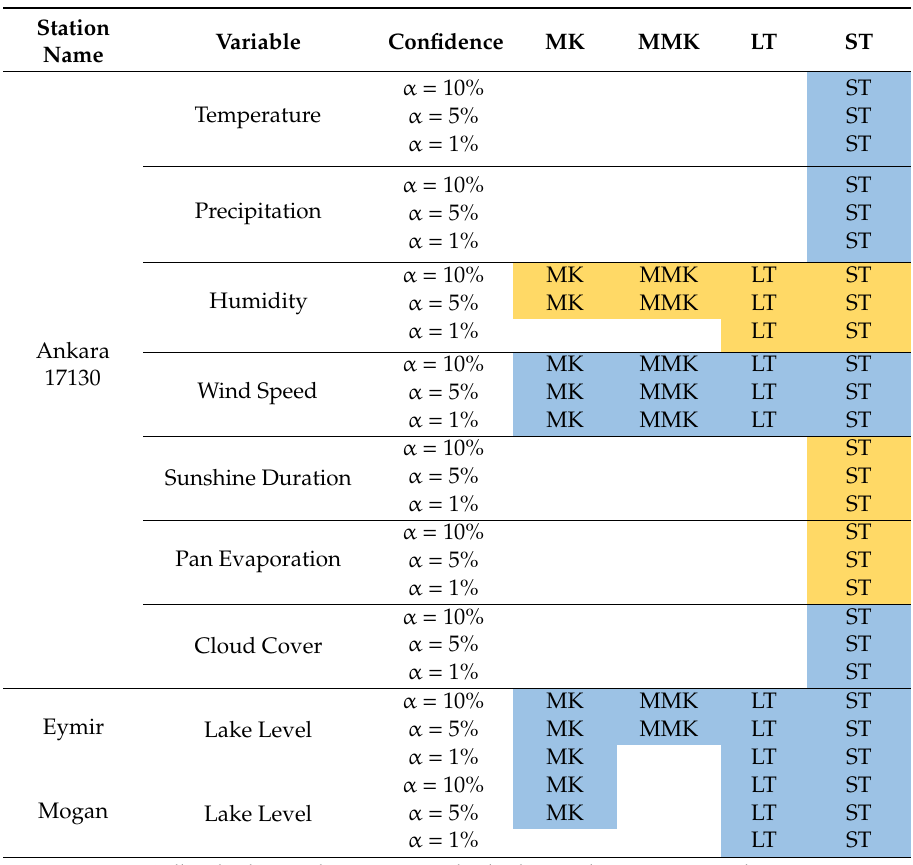
Table 7. Comparison of the results of the trend